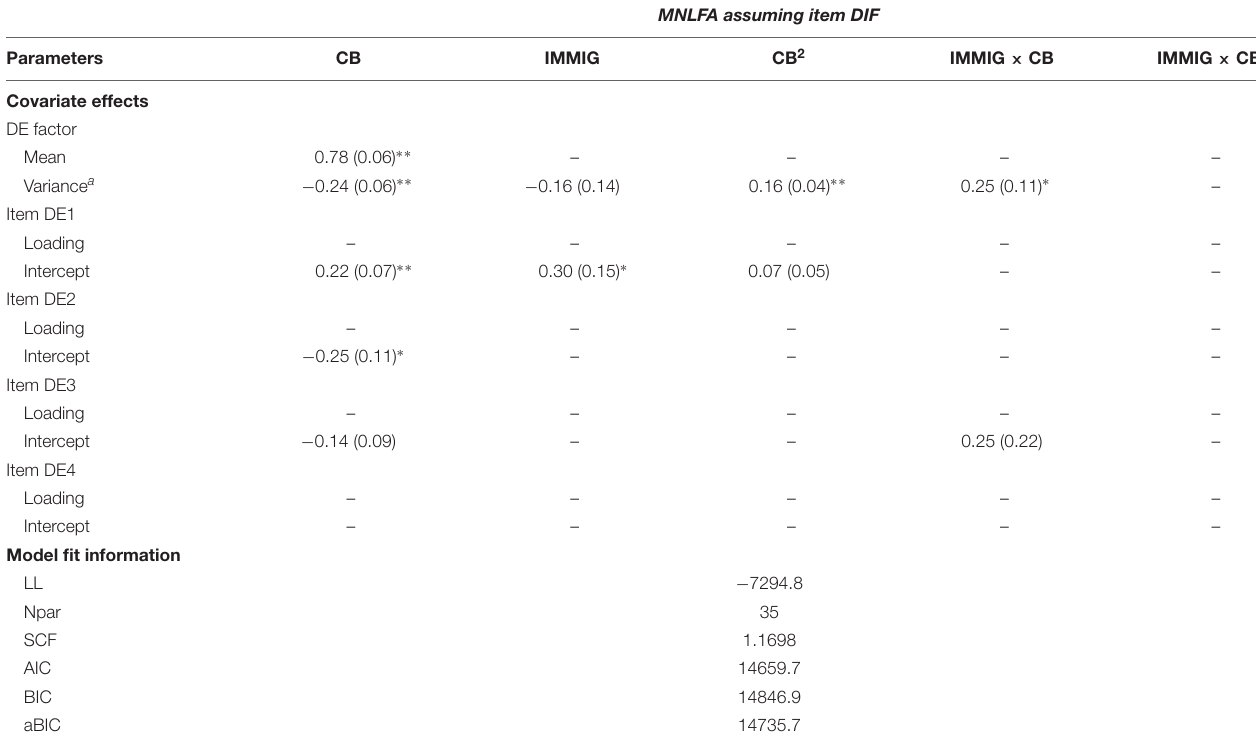
TABLE 4 | Unstandardized parameter estimates from the MNLFA models with cognitive-behavioral adaptability, students’ immigration status, and their interaction as